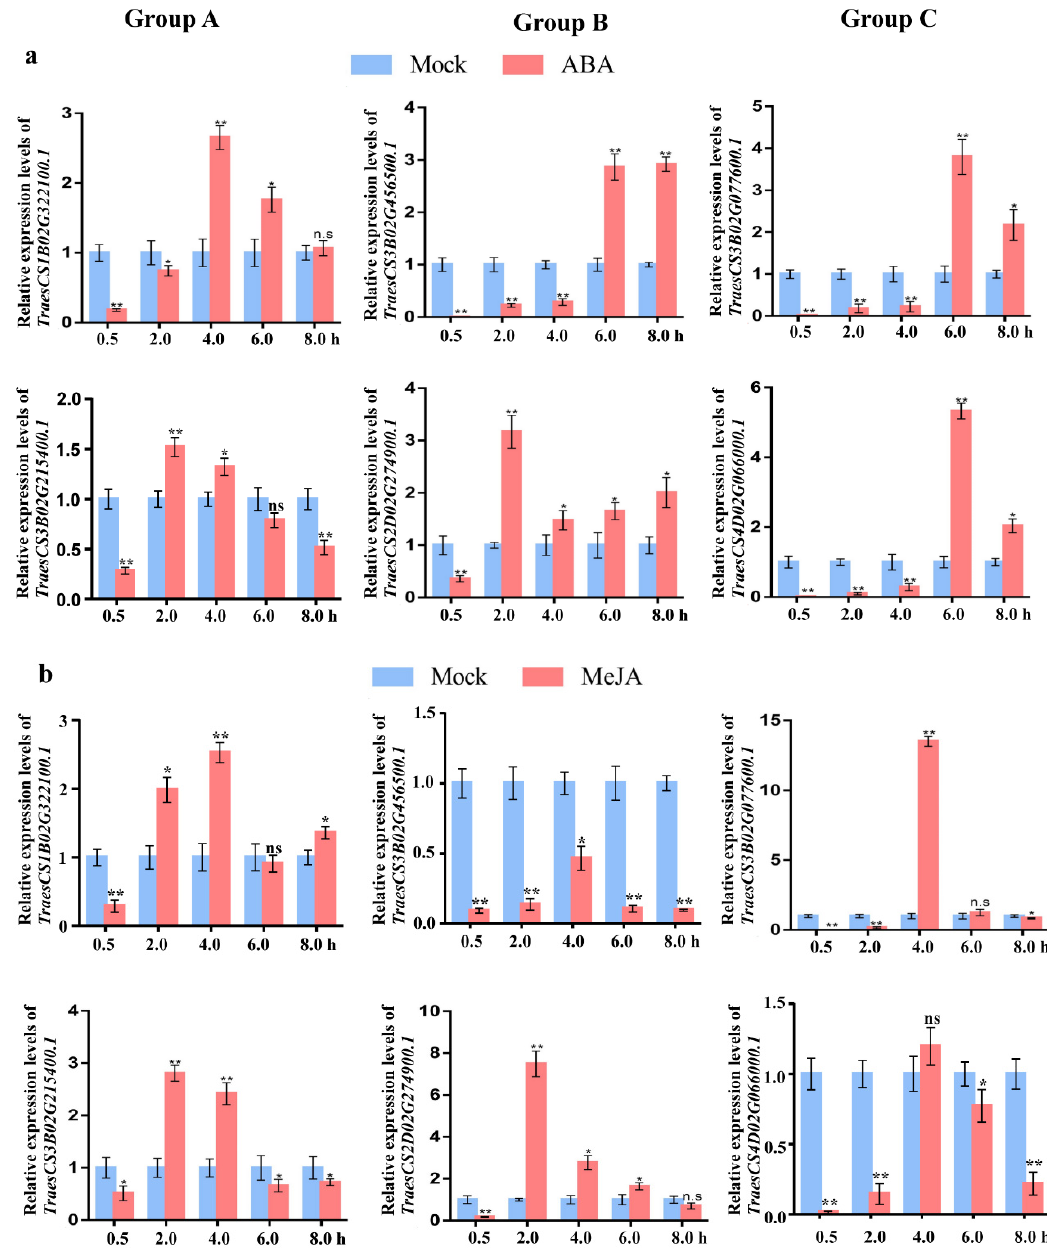
Figure 8. Expression pattern analysis of TaCystatin genes upon hormone applications. ( a ) Relative expression levels of six selected TaCystatin genes at 0.5, 2, 4, 6, and 8 h after 100 μ mol L − 1 ABA treatments. Means ± standard deviations (SE) were deciphered from three biological replicates and each biological replicate had three technical replicates. Note: ns, not significant; **, p < 0.01; and *, p < 0.05 (Student’s t -test). ( b ) Relative expression levels of six selected TaCystatin genes at 0.5, 2, 4, 6, and 8 h after 100 μ mol L − 1 MeJA treatments. Means ± standard deviations (SE) were deciphered from three biological replicates and each biological replicate had three technical replicates. Note: ns, not significant; **, p < 0.01; and *, p < 0.05 (Student’s t -test). Plants treated with 0.1% Triton X-100 were used as the mock control.